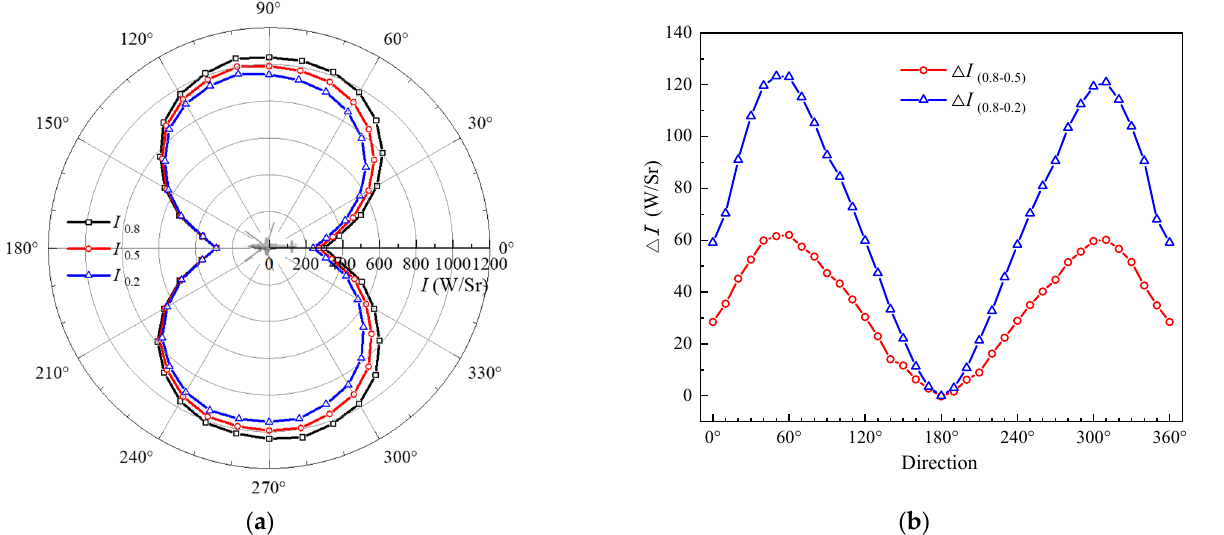
Figure 15. Infrared radiation intensity of helicopters with different rear fuselage surface emissivities in 8–14 µm band. ( a ) Infrared distribution characteristics; and ( b ) suppression value.